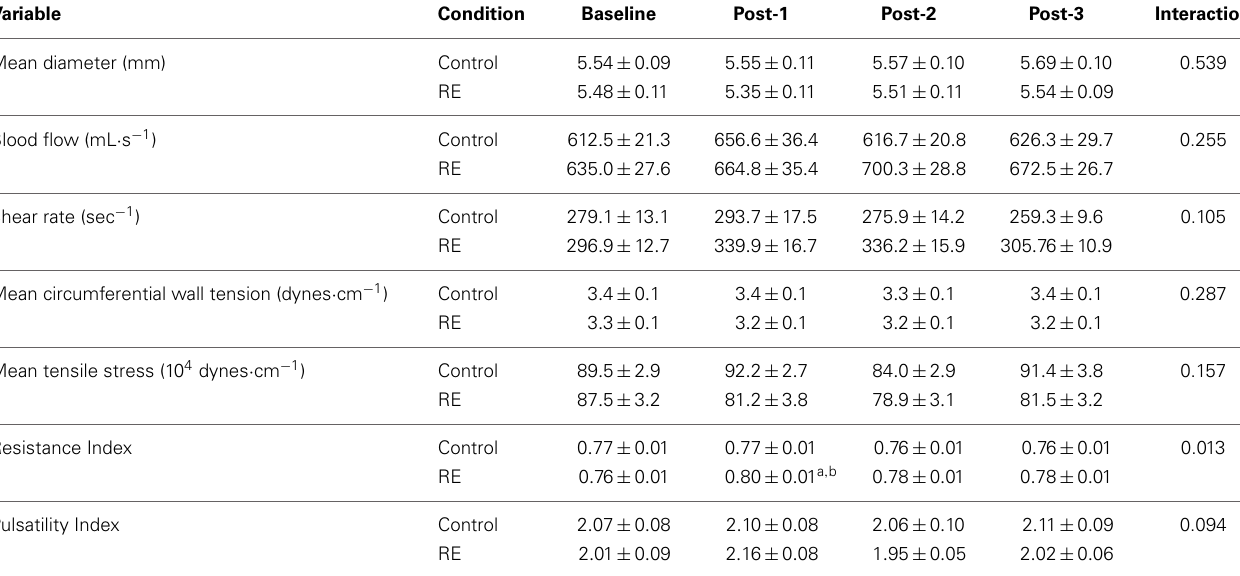
a Significantly different from within-condition baseline, p < 0.05. b Significantly different from other condition, same time point, p < 0.05. Table 2 | Common carotid dimensions/hemodynamics across testing time points between control and resistance exercise ( n = 18).